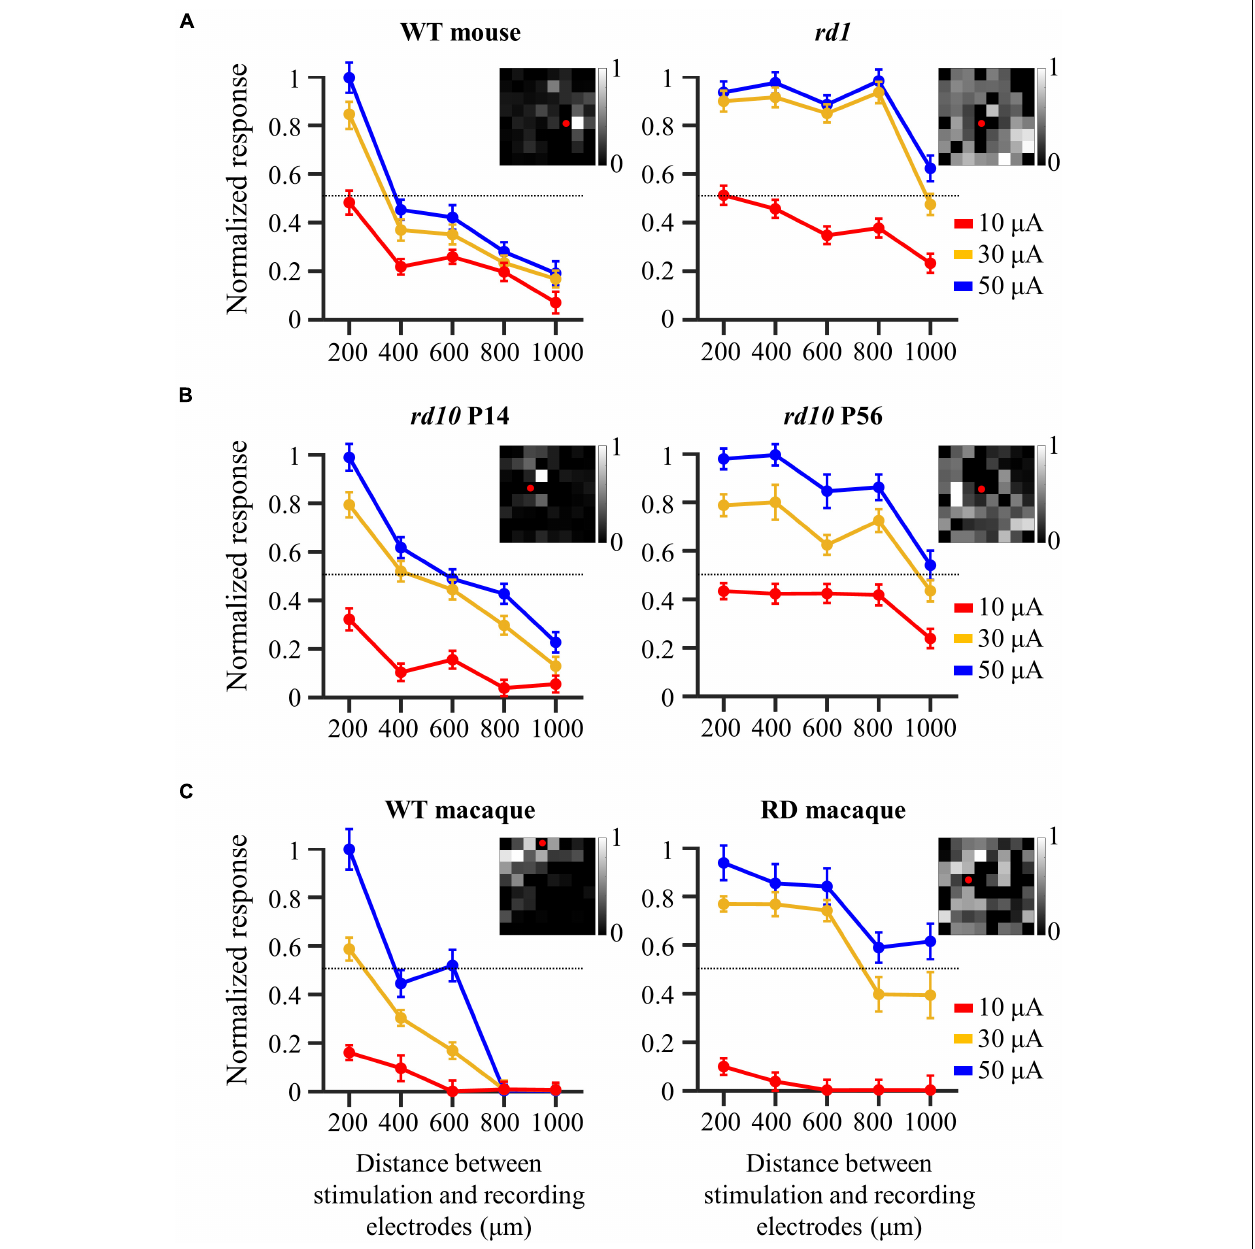
FIGURE 4 | Wide-spreading distribution of electrically evoked RGC population in the degenerate retina. (A) Changes in normalized RGC response with the distance between stimulation and recording electrodes in wild-type and rd1 mice. (B) Changes in normalized RGC response with the distance between stimulation and recording electrodes in rd10 P14 and rd10 P56. (C) Changes in normalized RGC response with the distance between stimulation and recording electrodes in wild-type and RD macaque. Insets in A, B, and C represent the spatial MEA colormap (grayscale) for normalized RGC responses upon electrical stimulation with a pulse amplitude of 50 µ A and a pulse duration of 500 µ s in one representative retinal patch. Red dots represent the position of stimulation